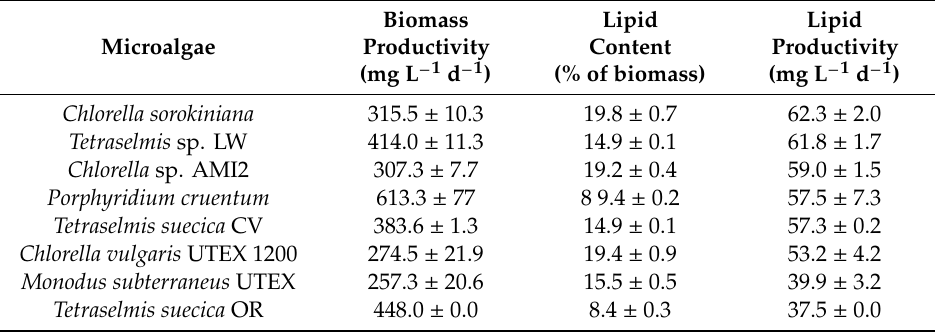
Table 1. Lipid content of di ff erent algal species